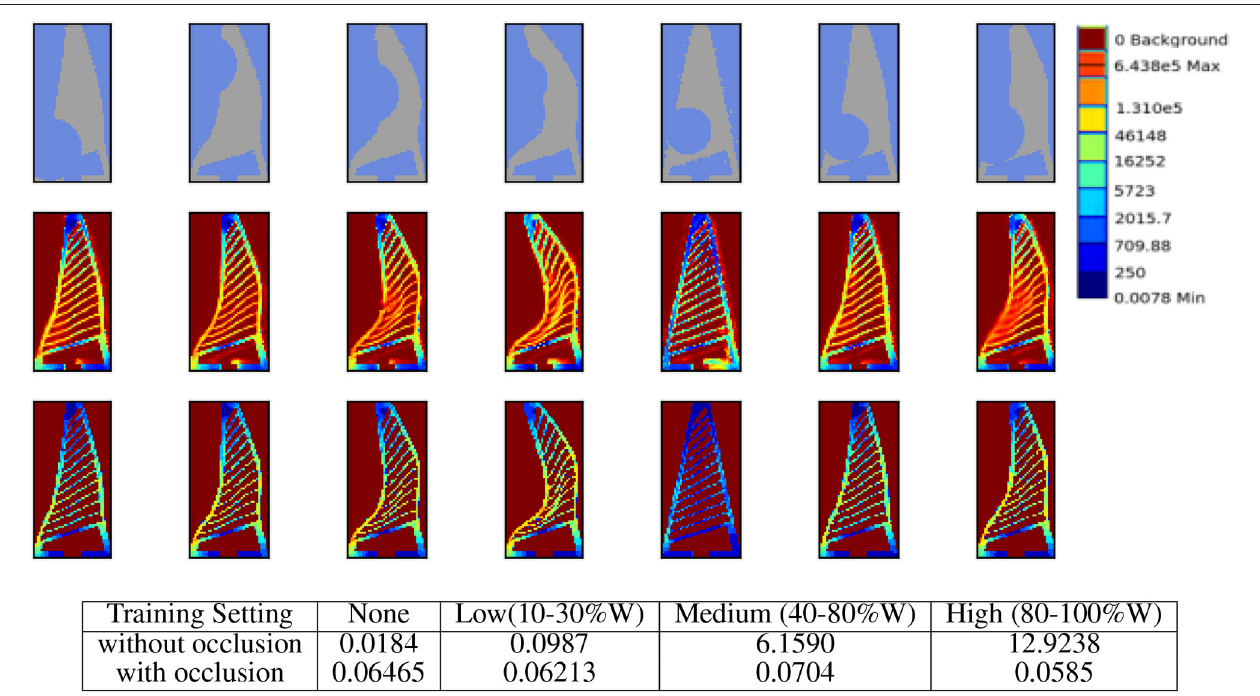
FIGURE 13 | Response to partial occlusion. (First-row) Input images with medium to high levels occlusion. (Second-row) Stress-map predicted by the approach in spite of occlusion. (Third-row) The ground truth stress maps generated from FEA. (Bottom) Quantitative results on force predictions under partial occlusions with and without retraining the network. Rows of the table denote the training setting i.e., with or without occlusion. While the columns of the table denote the various level of occlusions in while testing the network. The occlusion is simulated by a circle with diameter as fraction of image width (W) placed at randomly selected coordinates. For the medium level of occlusion, the diameter of the occluding circle is between 40 and 80% width of the image. The results are averaged over 10 trials to maintain consistency since occlusion is selected